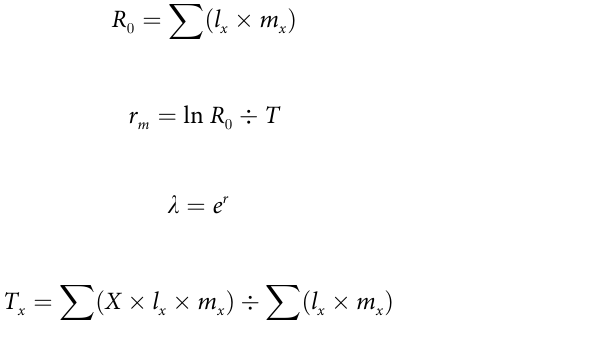
2.3.4 Leslie matrix construction. The Leslie matrix is one of the best-known methods for describing the growth of populations; it is used in ecology to model changes in populations of organisms over a period of time [31]. P (the sum of survival rates from age interval x ) was cal- x culated on the basis of survival rate ( l ) from the specific-time life table and f (the average x x number of progeny that were produced by X-age adults and survived to the next age) was cal- culated by using data from the fertility table.